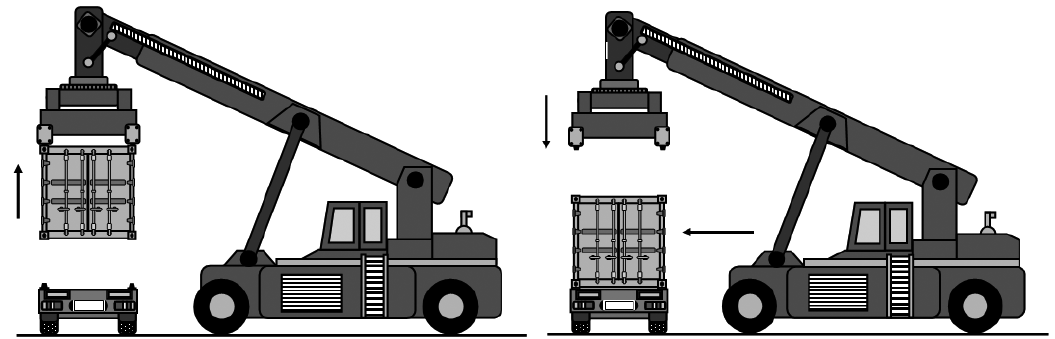
Figure 1. Operation No. 1 – raising a large type A cargo container from a tractor-trailer. Source: own work.